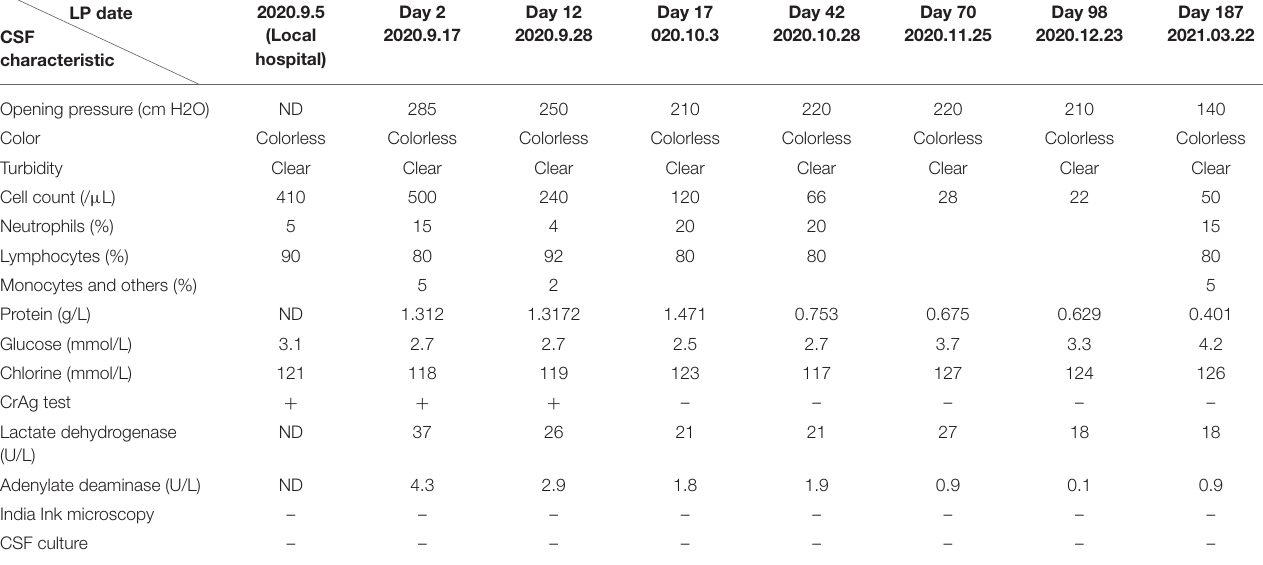
TABLE 1 | Cerebrospinal fluid profile evolution throughout treatment.